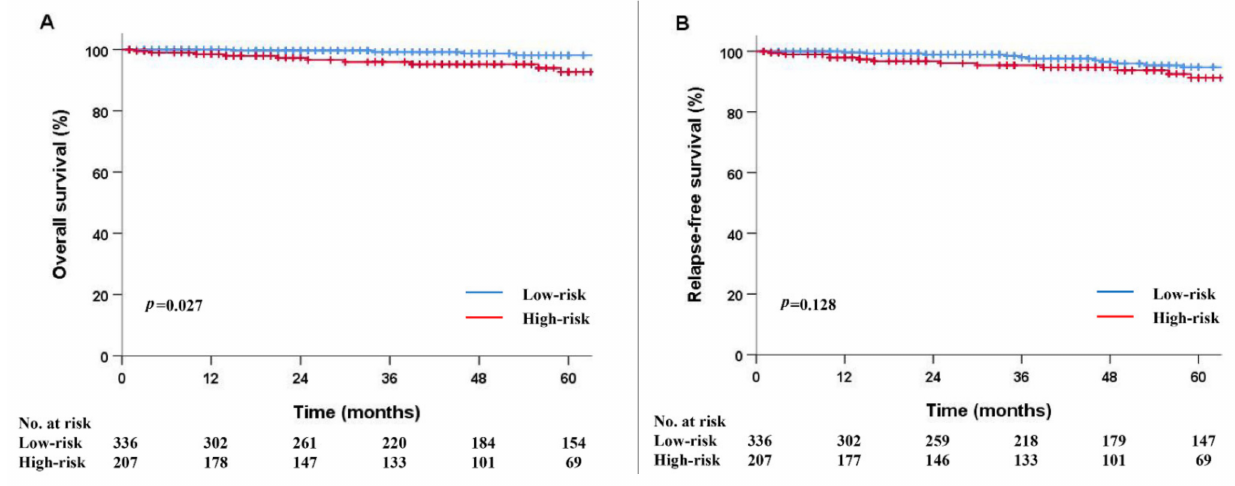
Figure 2. Kaplan–Meier survival curves between the low and high-risk groups. Overall survival ( A ) and relapse-free survival ( B